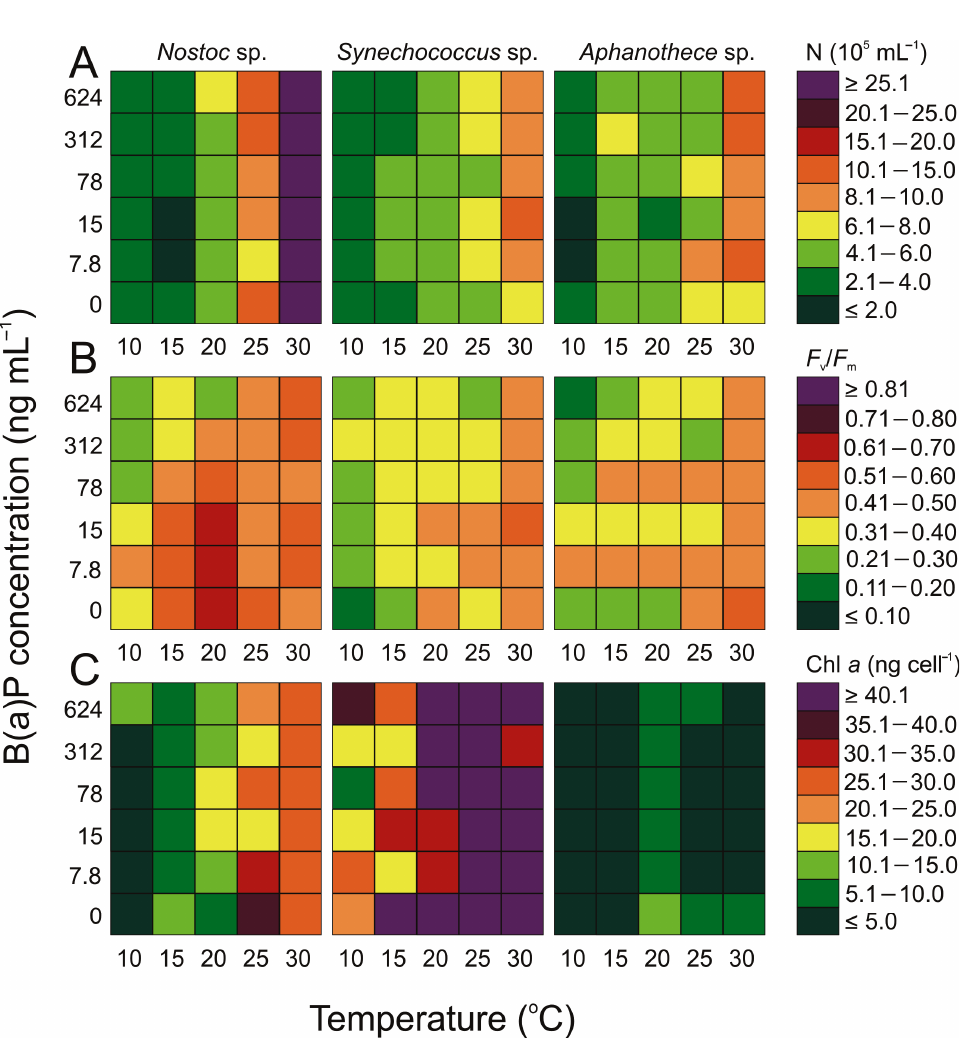
the lowest number of Ni tz chia sp. and Amphora sp. were recorded: 1.3·× 10 5 cell mL − 1 and 2.32·× 10 5 cell mL − 1 , respectively. The addition of a low concentration of B(a)P (7.8 ng mL − 1 )